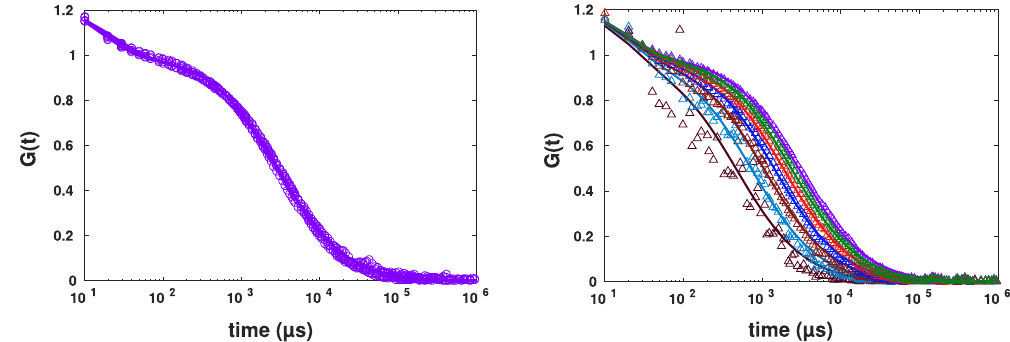
Figure 9. Diffusion time of AlexaFluor647-labeled streptavidin in buffer (blue) and in buffer crowded with 30% PEG1500 (red) versus spot size, together with corresponding linear fits being τ = − r 222 11 02 with Pearson r 2 = 0.997. Data are presented as means ± standard deviation r 2 = 0.995 and τ = − r 1, 111 23 d from N = 6 independent experiments.